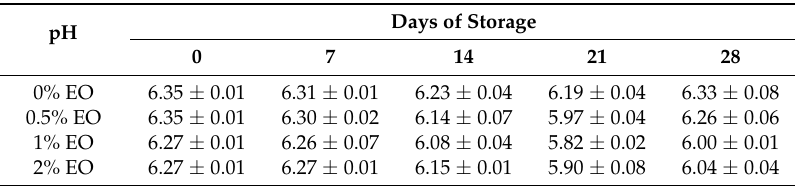
Table 3. pH values (mean ± standard deviation) in RTE meat packaged during refrigerated storage (0% EO: control films; 0.5% EO: films with 0.5% thyme essential oil; 1% EO: films with 1% thyme essential oil; 2% EO: films with 2% thyme essential oil).